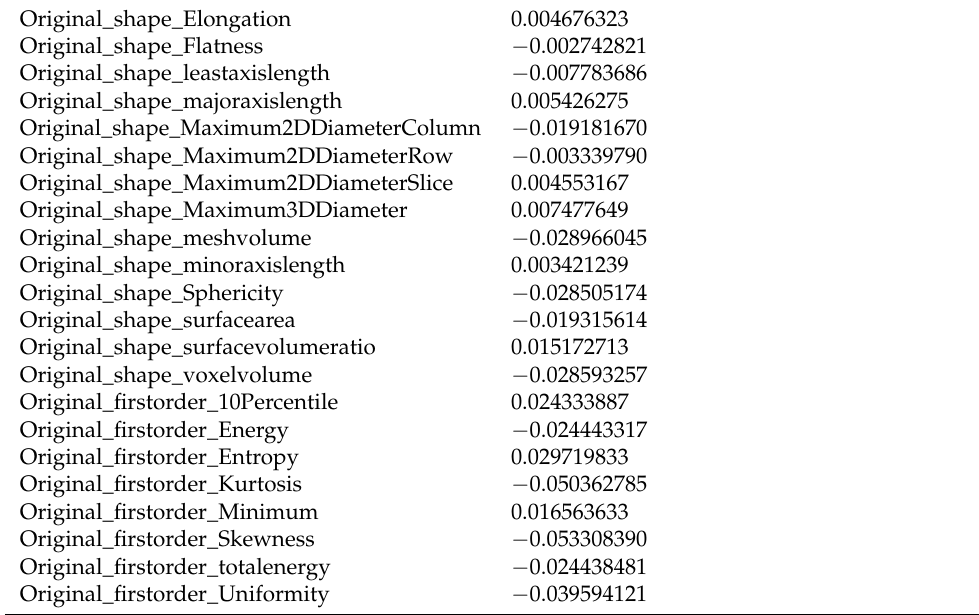
Figure A1. ROC-curve using delta DWI parameters. Responders vs. non-responders. Accuracy: 81.82% (59.72–94.81%). Sensitivity: 100%, Specificity: 69.23%. Table A3. Modelbuilding. Responders vs. non-responders.